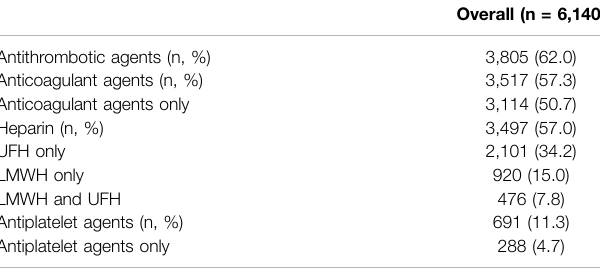
Adjusted HRs for antithrombosis agents and VAEs are summarized in Table 3 . Regimens with antithrombotic (HR: